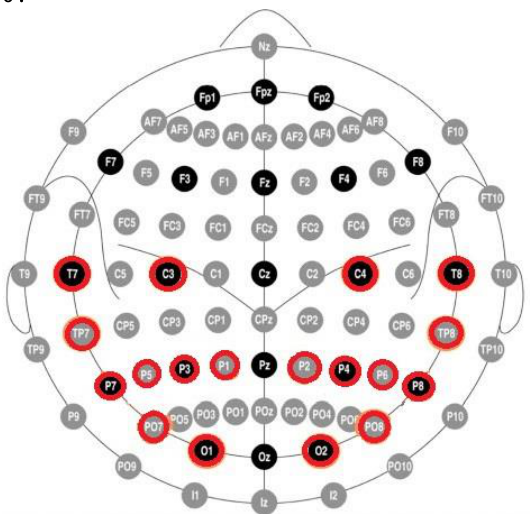
Figure 8. Position of selected electrodes on the international system 10-10.